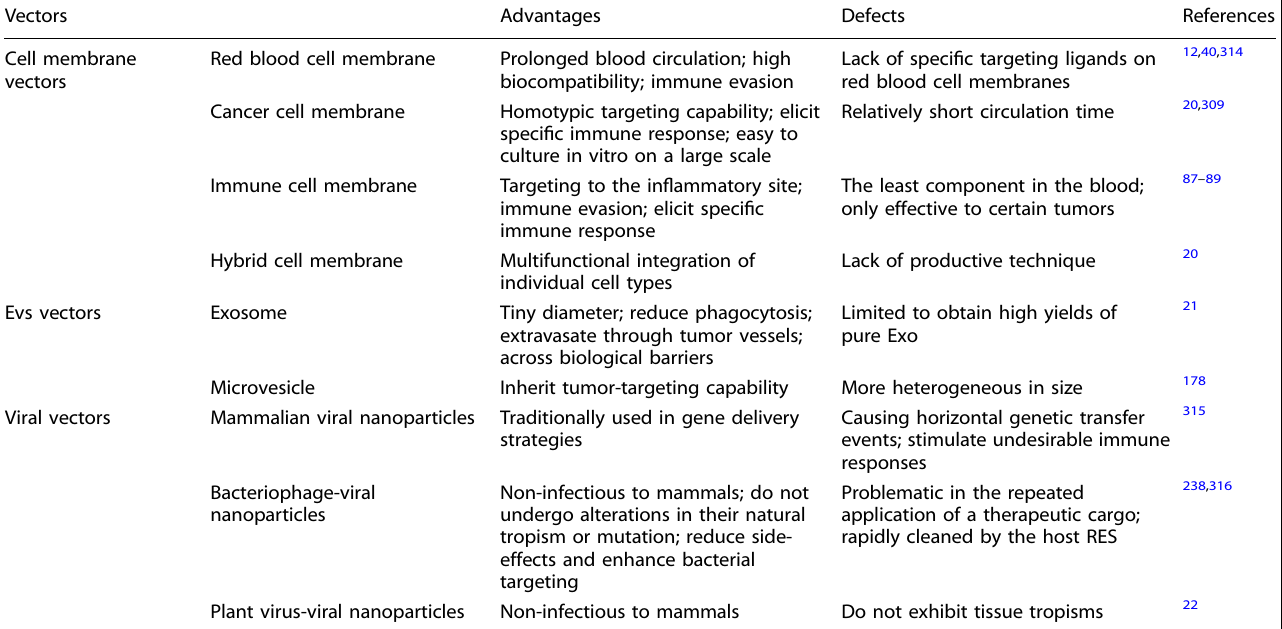
Table 1. Currently explored natural vectors for nanoparticles camou fl age Vectors Advantages